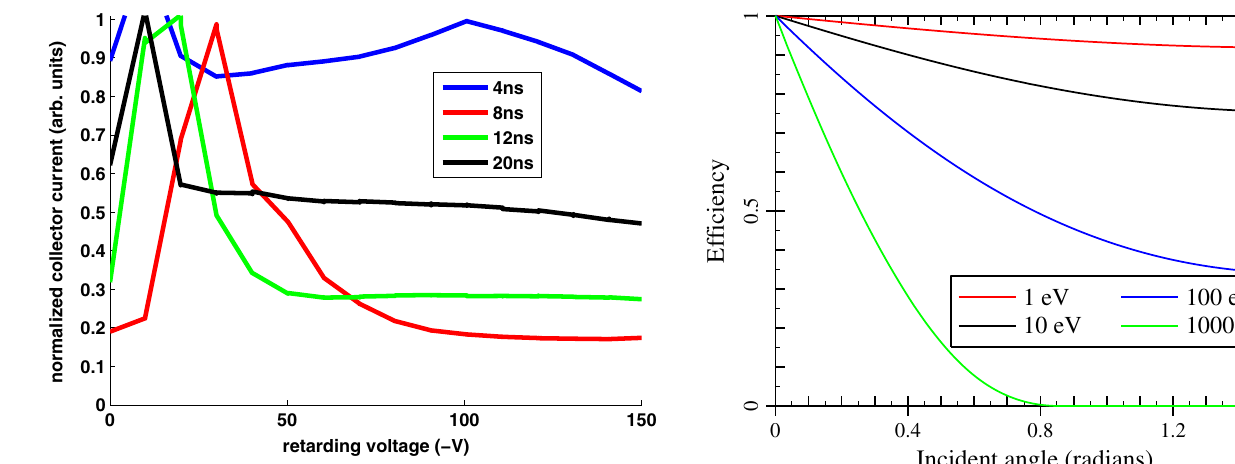
FIG. 10. Simulated RFA efficiency vs incident angle for the chicane dipole RFA, with a 810 gauss magnetic field.